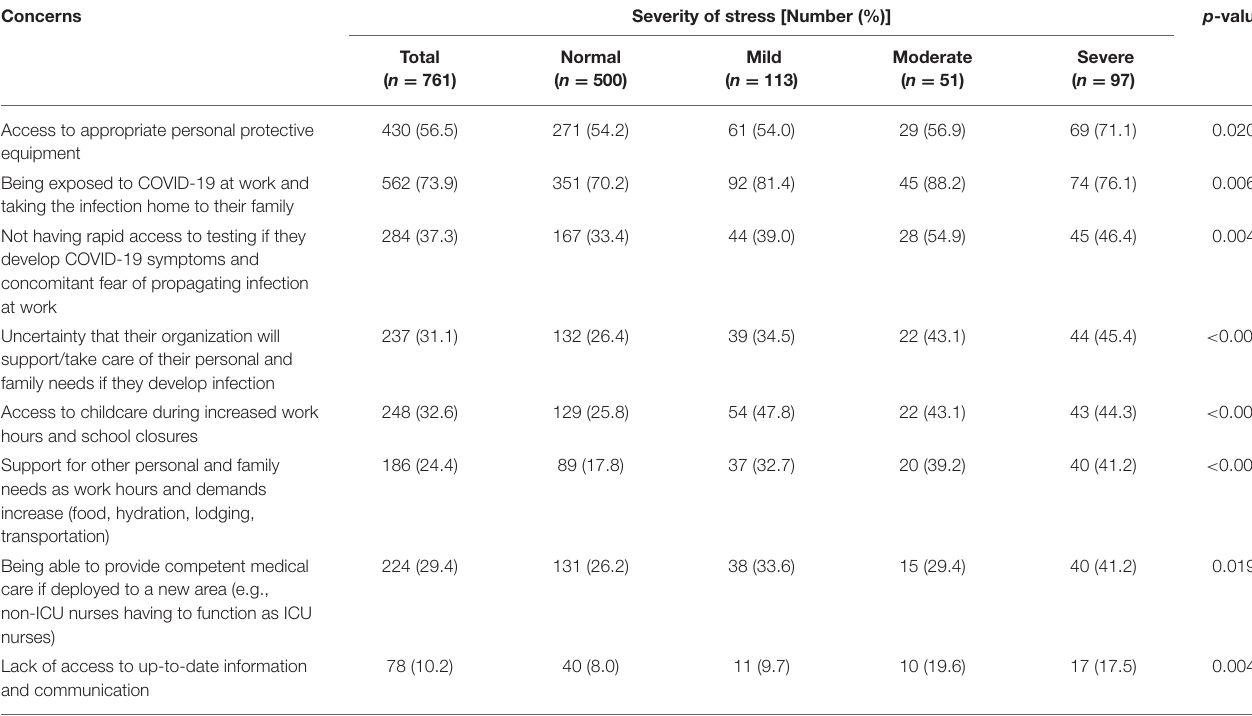
TABLE 2 | The association between stress severity level of HCWs and their COVID-19-related concerns during the COVID-19 outbreak in Vietnam. Concerns Severity of stress [Number (%)] p -value Total Normal ( n = 761) ( n =